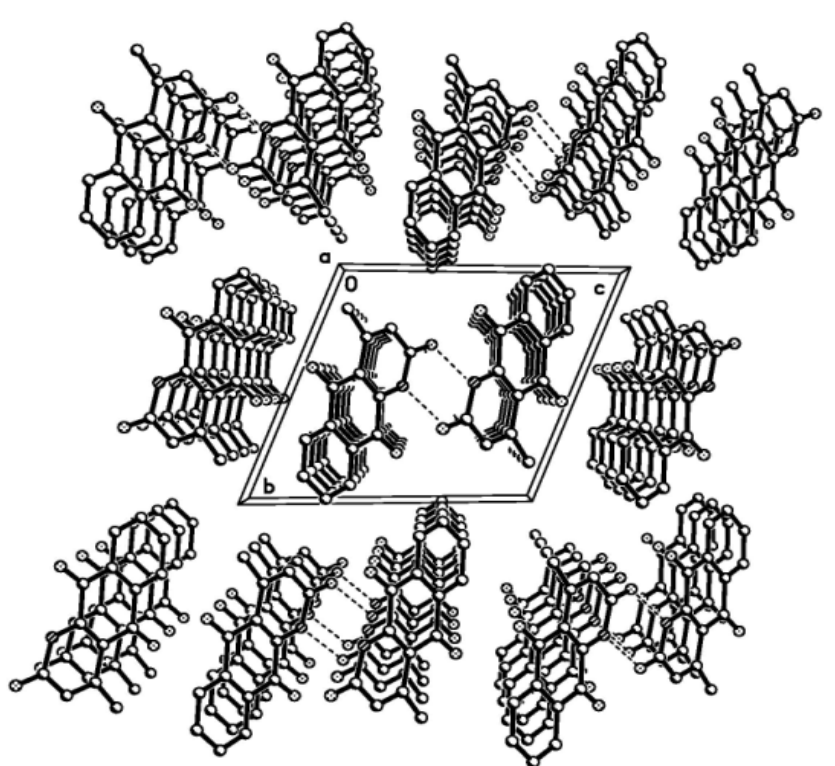
Figure 3. Packing of the molecules in a unit